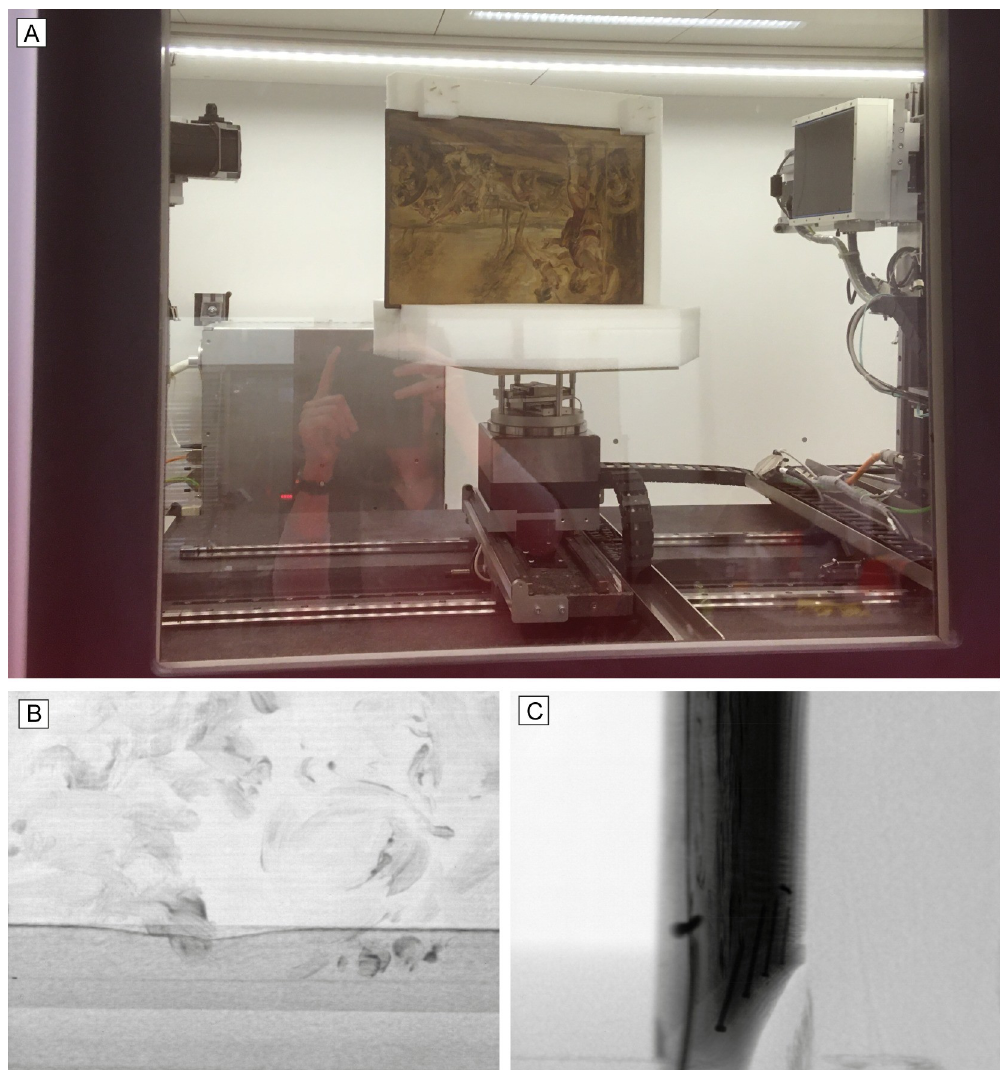
Fig 3. Scanning the Cadmus painting at the FleX-ray Lab. (A) Panel on the Ethafoam 1 mount placed on the rotation stage at approximately 90 degrees rotation. The vertical tiled scans are achieved by moving the source (on the left) and detector (on the right) up or down by the same distance, so that they stay directly opposite to each other; (B) X-ray image of Tile 2 at 0 degrees. The foam can be seen at the bottom, whereas the slightly darker area above represents the oak strip; (C) X-ray image of Tile 2 at 90 degrees. The X-rays must travel through approximately 44 times more wood in this direction. The nails that fix the oak strip to the panel can be